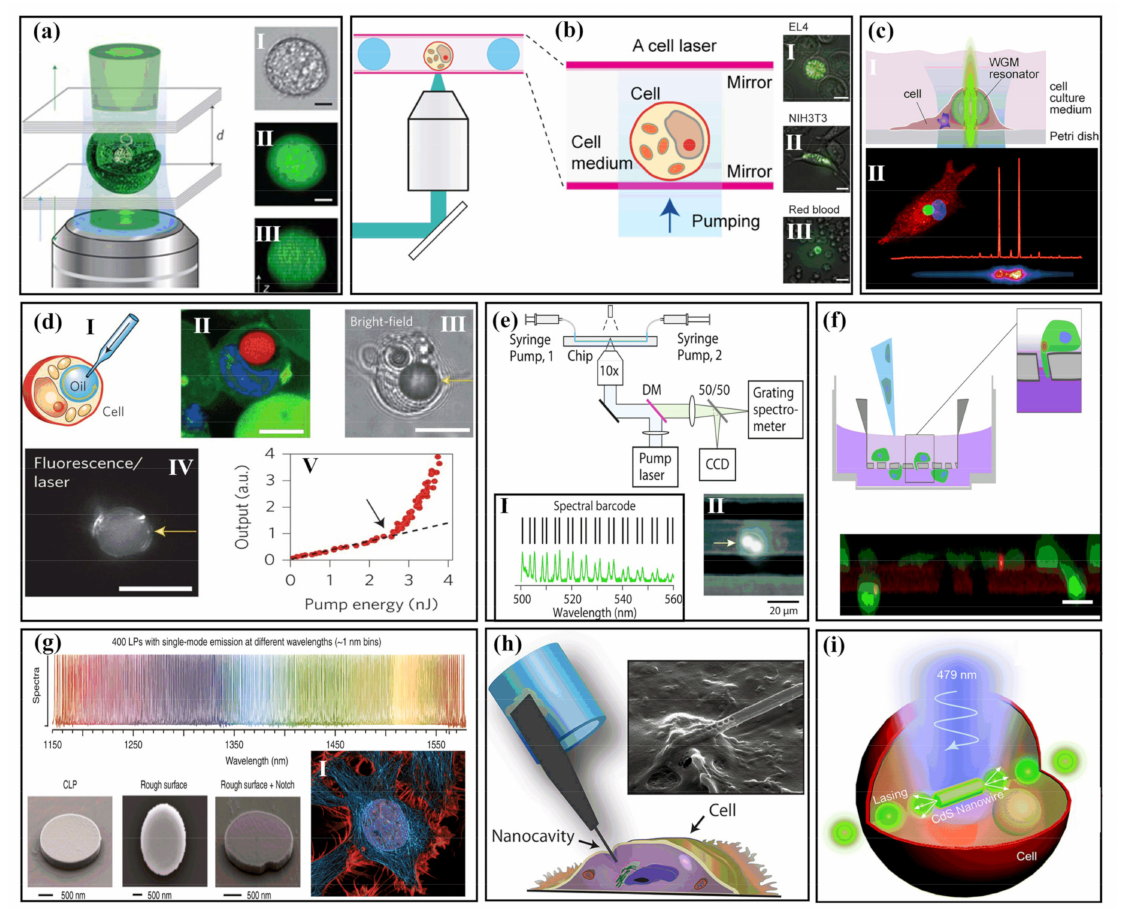
Figure 4. Cellular detection with biolaser. ( a ) Diagrams of the single-cell lasers. A living eGFP-expressing cell is captured by an FP cavity with two distributed Bragg reflectors. I–III: Figures of a single cell outside the cavity under the microscope. (Adapted with permission from [68]. Copyright 2011 Nature Publishing Group.) ( b ) Cells are injected between two highly reflective mirrors and then sink to the surface of the bottom mirror. The cells are irradiated in such a way that the whole cell or a series of cells is excited. Laser mode hyperspectral figures of various kinds of cells. I, II, III: Superposition of bright field picture and laser picture (Adapted with permission from [59]. Copyright 2015 Optical Society of America.) ( c ) I: Lasing based on live cells that internalize a microcavity. II: Cytoplasm (red), nuclei (blue), and internalized microsphere resonators (green) of macrophages from cellular laser spectroscopy and confocal laser scanning microscopy (CLSM) information. (Adapted with permission from [64]. Copyright 2015 American Chemical Society.) ( d ) I: Pictures of oil microinjection in the cytoplasm. II, III, IV: Cell pictures in the experiment. V: Plot of droplet output light intensity versus pump pulse energy, presenting obvious lasing threshold (marked by red arrow). (Adapted with permission from [61]. Copyright 2015 Nature Publishing Group.) ( e ) Schematic of the microfluidic laser optical setup. I: The wavelength series of WGM peaks recognized from the fluorescence subtraction spectra create the “spectral barcode” of cells. II: Diagram captured by CCD of a cell (marked by yellow arrow) with two beads. (Adapted with permission from [71]. Copyright 2017 The Royal Society of Chemistry.) ( f ) Sketch (top) and experiment picture (below) of the movement of cells that ingested nanodisk microcavities through the microporous membrane. (Adapted from [66].) ( g ) Combination map of 400 single-mode emission laser microcavities of distinct wavelengths. I: HeLa cells, defect-free semiconductor laser particles (CLPs), and surface-introduced defects give omnidirectional emission. (Adapted from [57].) ( h ) Photonic nanoprobe design and single-cell interrogation. (Adapted with permission from [69]. Copyright 2013 American Chemical Society.) ( i ) Graph of CdS NW lasing based on a cell. (Adapted with permission from [70]. Copyright 2018 The Royal Society of